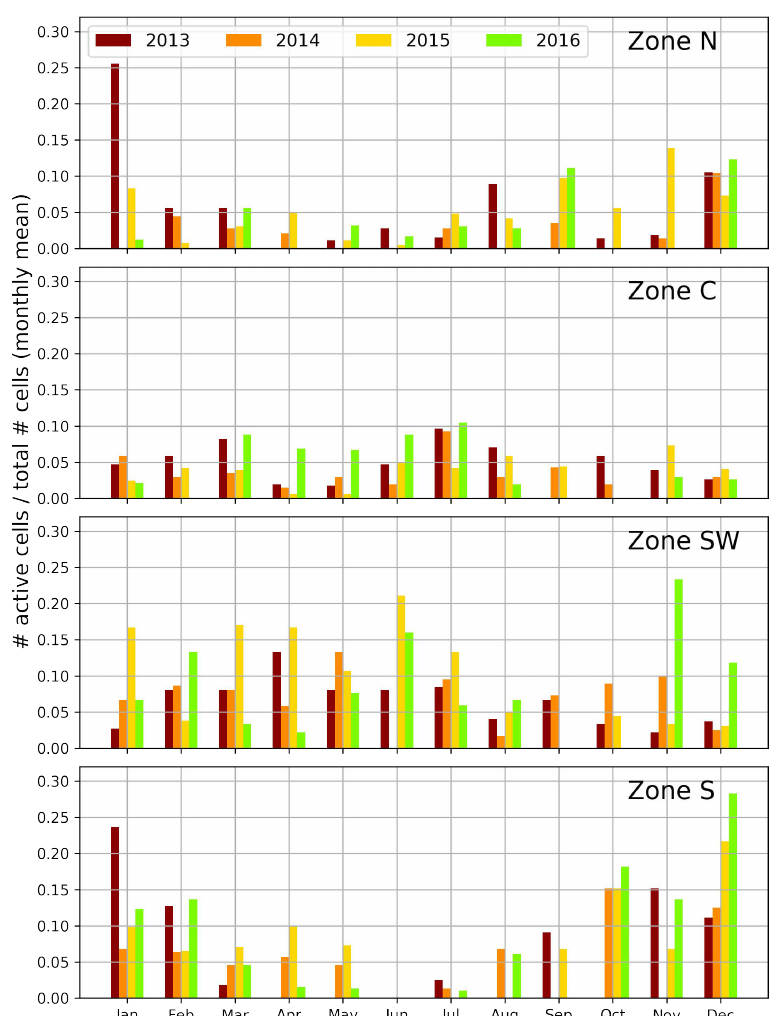
Figure 6. Monthly mean dust activity for all grid cells within each of the four hot-spot